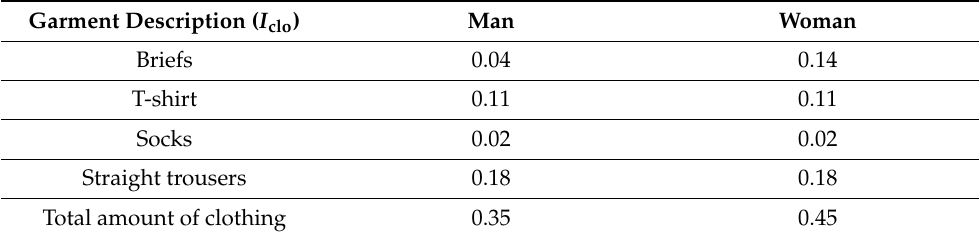
Table 8. Garment insulation